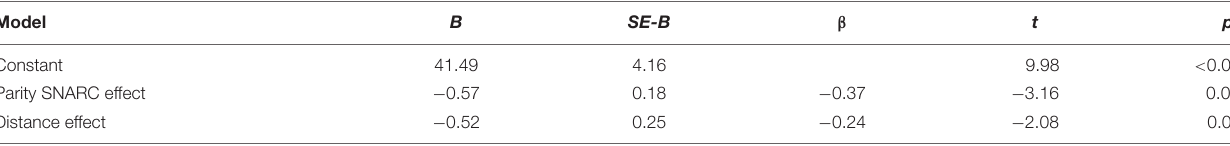
TABLE 4 | Stepwise multiple linear regression analysis on math anxiety